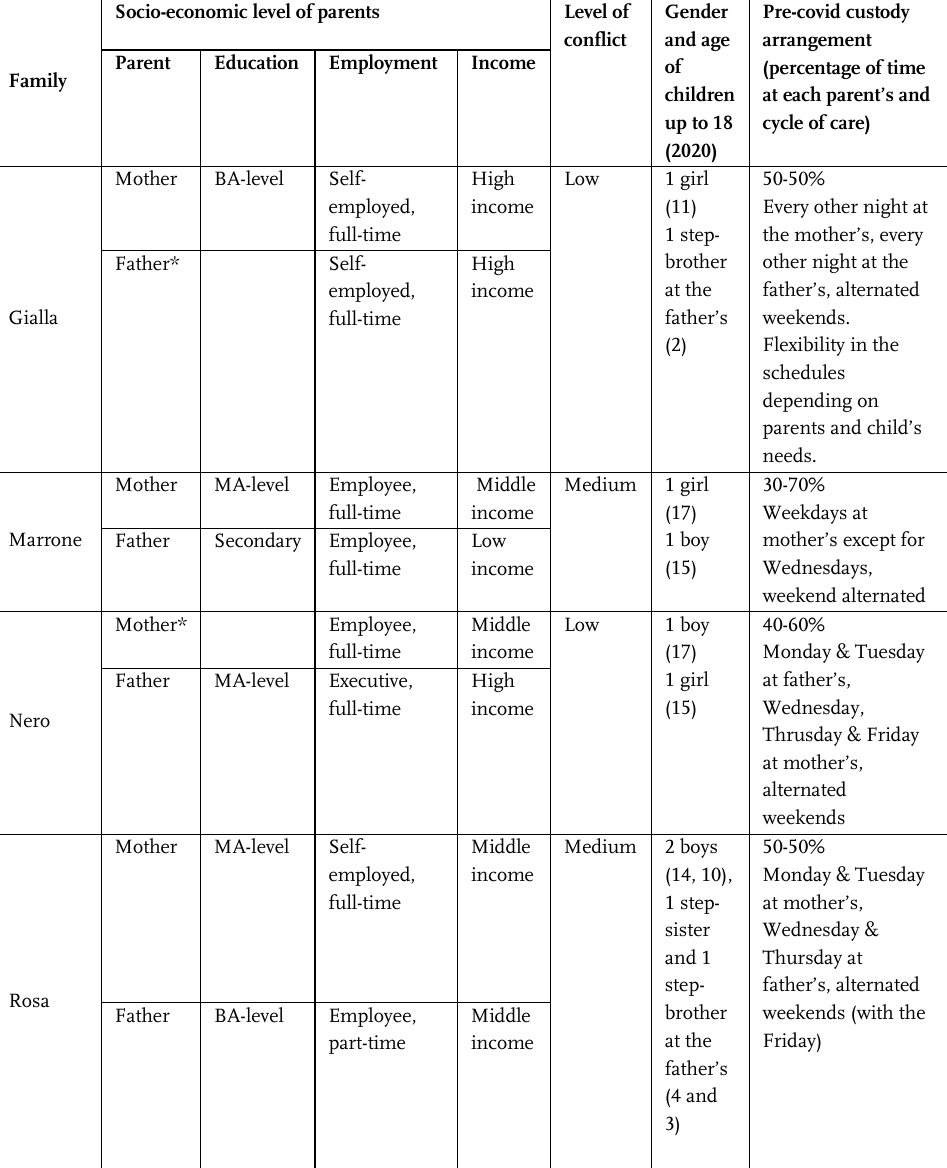
Table 1: Family profiles and custody arrangements before Lockdown (continued)